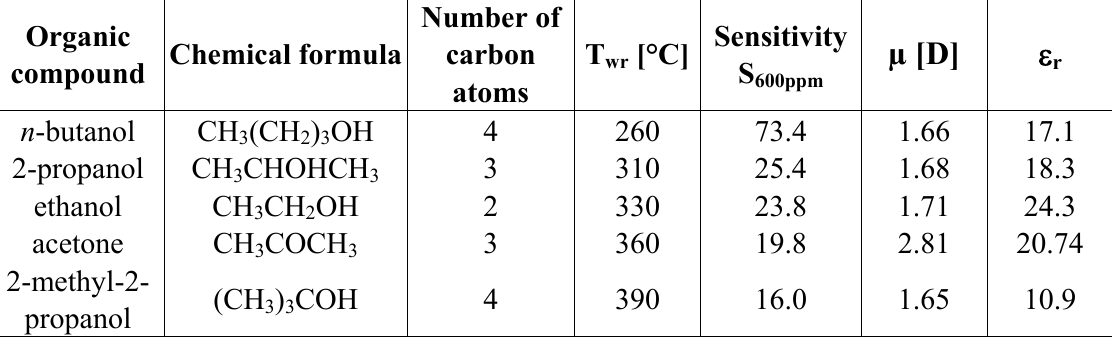
Table 1. Working temperature (T atmosphere containing different organic